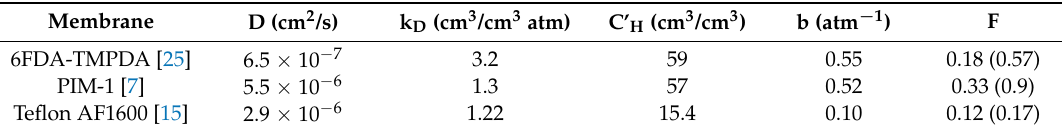
Table 4. CO 2 permeability and competitive sorption parameters for 6FDA-TMPDA, PIM-1 and Teflon AF1600, taken from the literature. The F values are calculated from the data, with those values in brackets corresponding to